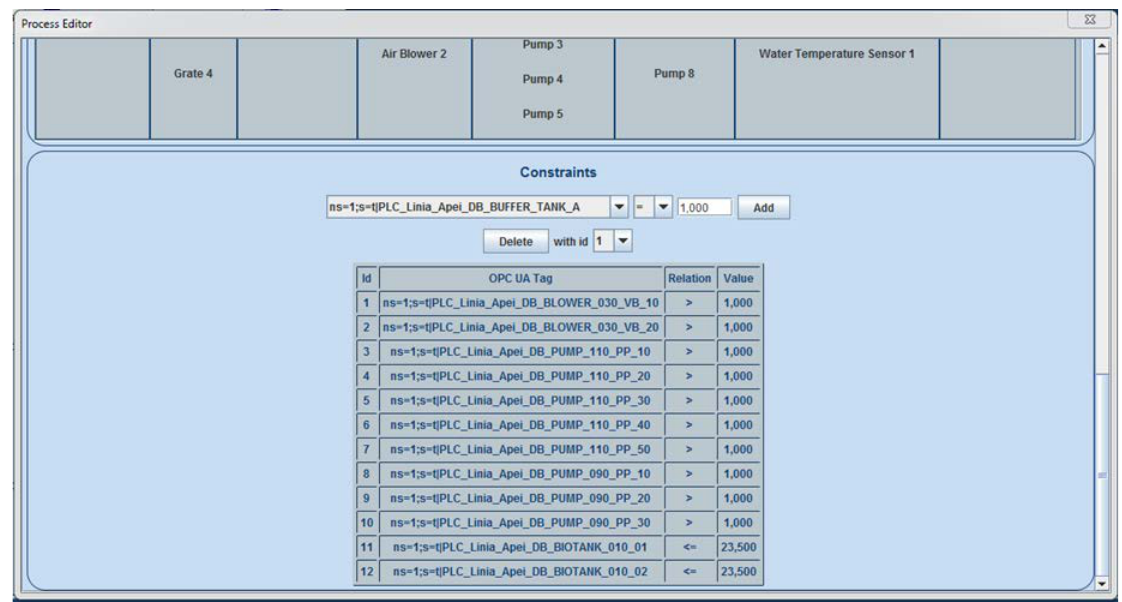
Figure 6. WWTP process constraints in the Historian Process Editor.